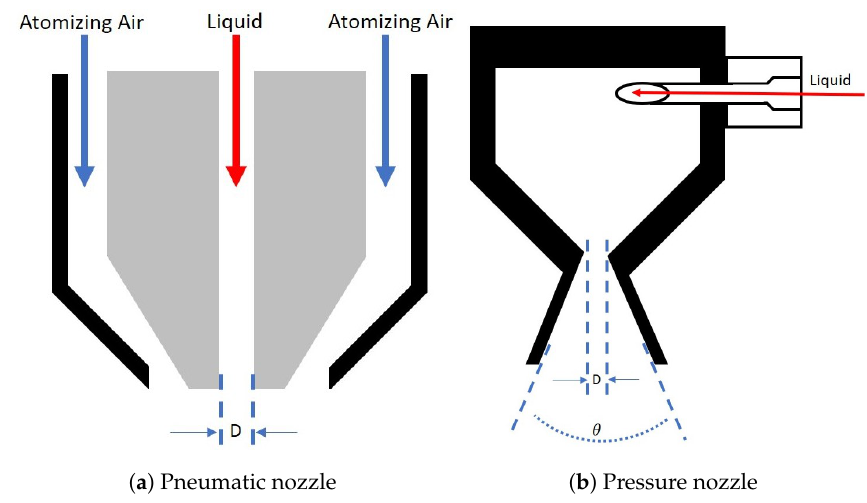
Figure 3. Schematics of the two different nozzles of diameter